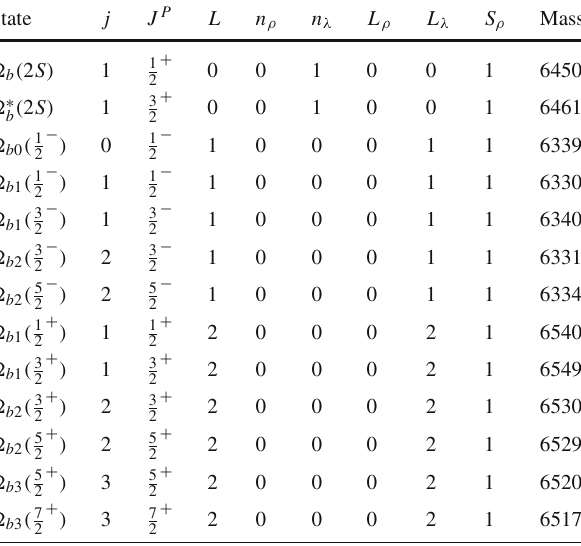
Table 1 Notations, quantum numbers and masses of initial baryons. The n ρ and L ρ denote the nodal quantum number and orbital angular momentumbetweenthetwostrangequarks,respectively.The n λ and L λ represent the the nodal quantum number and orbital angular momentum between the bottom quark and strange quark system. The S ρ stands for the total spin of the two strange quarks, L is the total orbital angular momentum, j represent total angular momentum of L and S ρ , J is the total angular momentum, and P is the parity. The masses are taken from the theoretical predictions from relativistic quark model [9]. The units are in